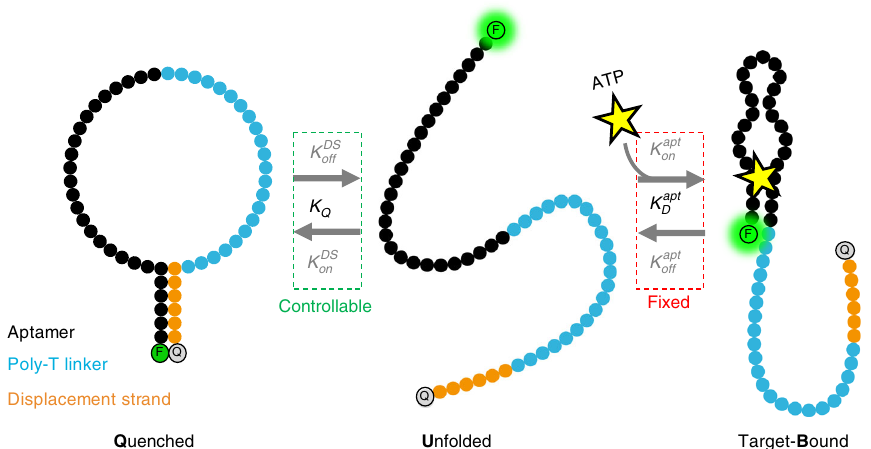
Fig. 1 Overview of the intramolecular strand-displacement (ISD) switch design. We use an ISD design to convert an existing aptamer into a switch that gives a target-concentration-dependent signal based on the interaction of a fl uorophore-quencher pair at the 5 ′ - and 3 ′ - ends of the construct, respectively. In this three-state population shift model, signal is generated by the unfolded and target-bound forms. In the absence of target, the quenched and unfolded states are in equilibrium, de fi ned by K Q . Target binding depletes the unfolded population, and the reaction shifts to the right, generating a signal that is proportional to target concentration. We use this model here to generalize the discussion and insights to other aptamers; however, since the ATP aptamer has two binding sites 20 , we have used a modi fi ed two-site binding model for fi tting and calculations (Supplementary Fig. 2, Supplementary Eq. 1)